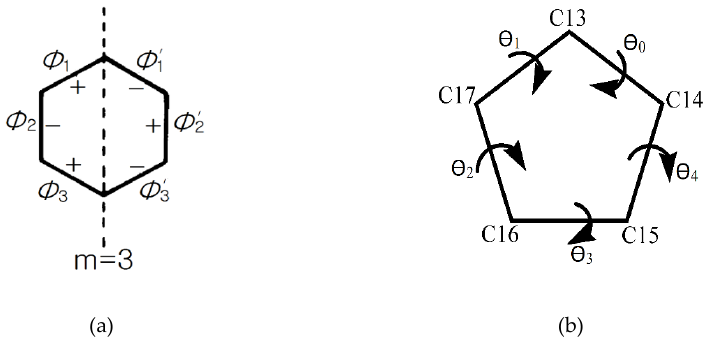
Figure 12. Torsion angles related by mirror planes considered for ∆ C s display opposite signs ( a ) torsional angles related to the angle of pseudorotion P and the maximum angle of torsion τ m in five membered rings ( b ).